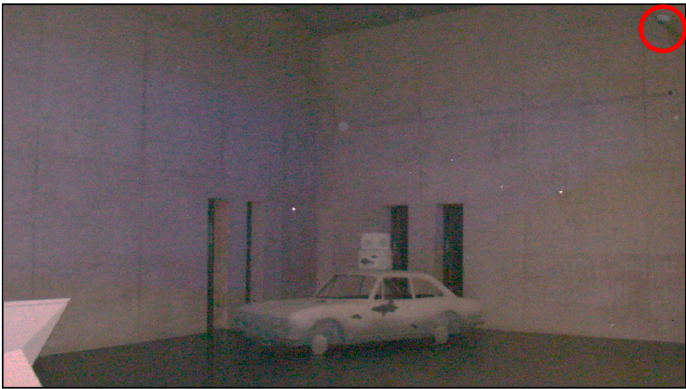
Figure 3. Under surveillance, and not going anywhere; Luxembourg Freeport (photo by the author).